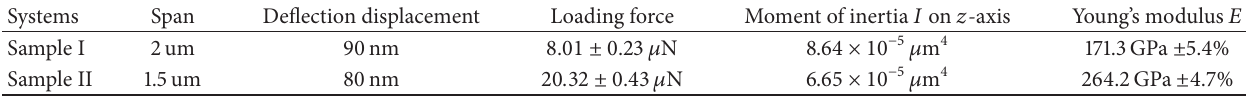
Table 1: The experimentally measured data and calculating results of GaN nanobeam systems with different span.